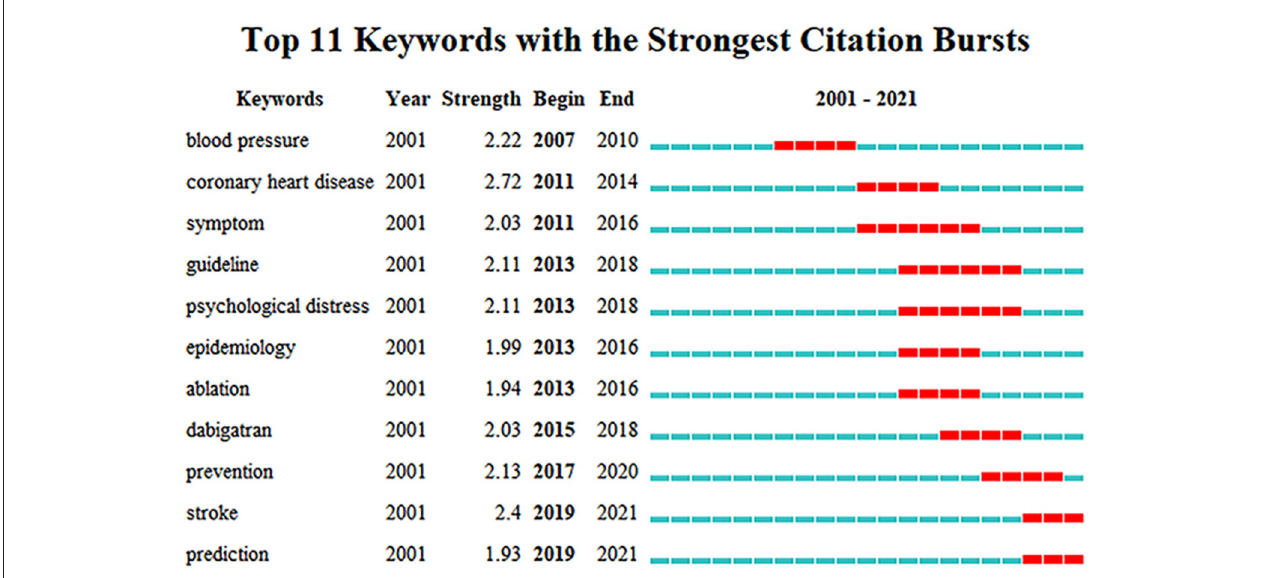
FIGURE 7 | Top 11 keywords with the strongest citation bursts. Begin and End represent the beginning and end years of keyword emergence respectively. Strength indicates the intensity of the cited change. Each red or blue bar represents the time interval, and a single bar is equal to one year. The red bar especially represents citation